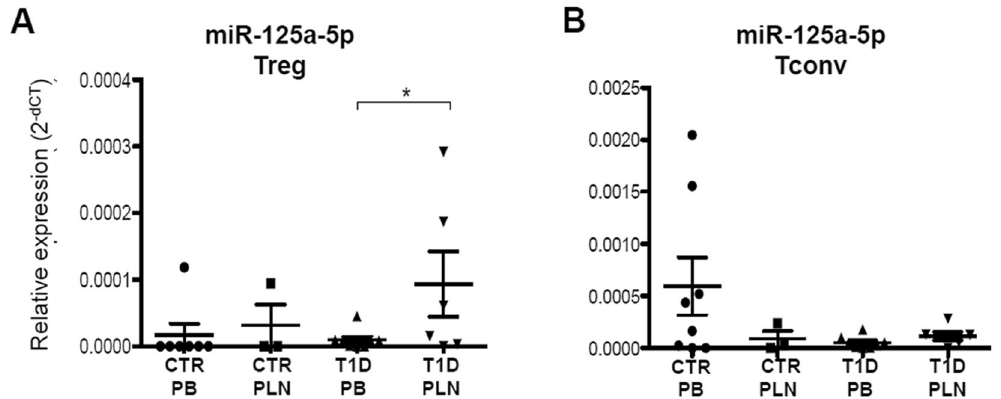
Figure 2. miR-125a-5p is selectively hyper-expressed in Treg cells isolated from PLN of patients with T1D. miR-125a-5p expression was measured by real time-PCR in Treg cells (A) and Tconv cells (B ) purified from peripheral blood (PB) of non-diabetic control (CTR) donors (n = 8), pancreatic lymph nodes (PLN) of controls (n = 3) and from PB (n = 8) and PLN (n = 5) of patients with T1D. Expression values are reported as 2^-delta cycle threshold (2 − dCT ) values normalized using three different small RNAs (RNU6, RNU44, RNU48). * p < 0.05 student’s t test